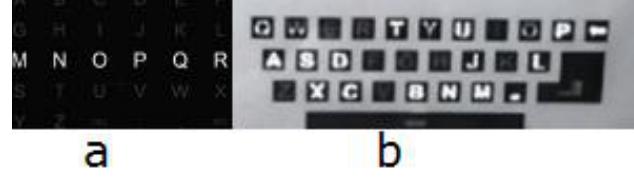
Fig. 3. Spellers based on (a) P300 (b) SSVEP. Sources: [26],[13]. In BCIs, processing can be performed online and